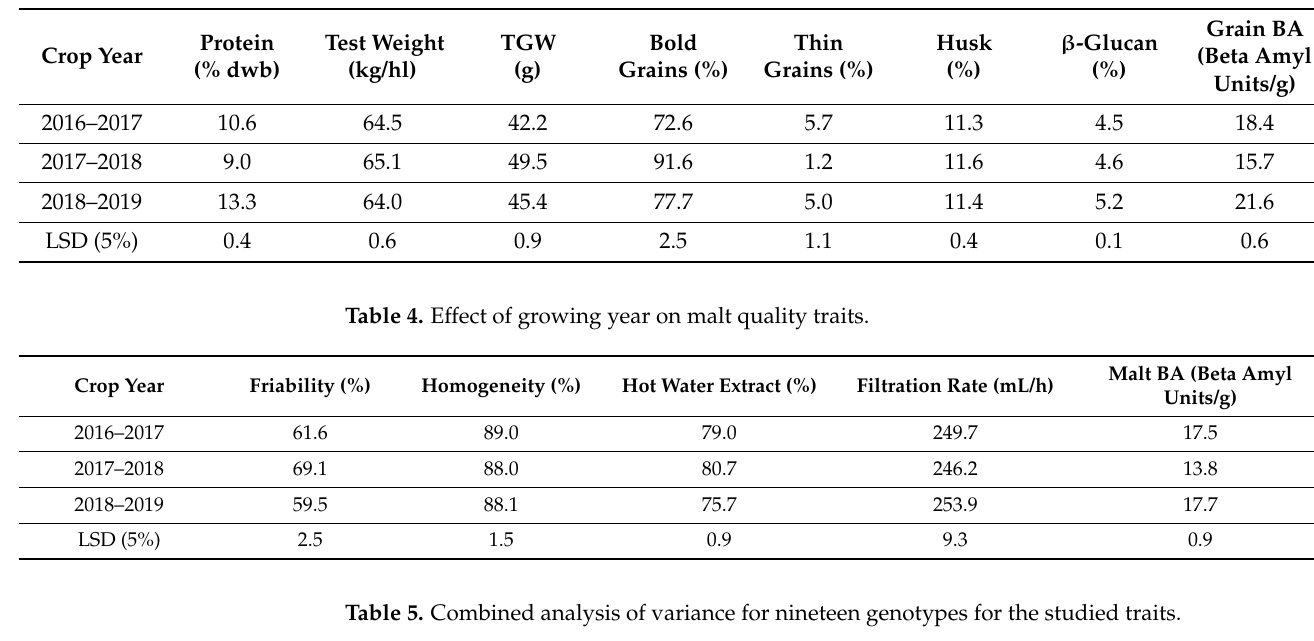
Table 3. Effect of growing year on grain quality traits.